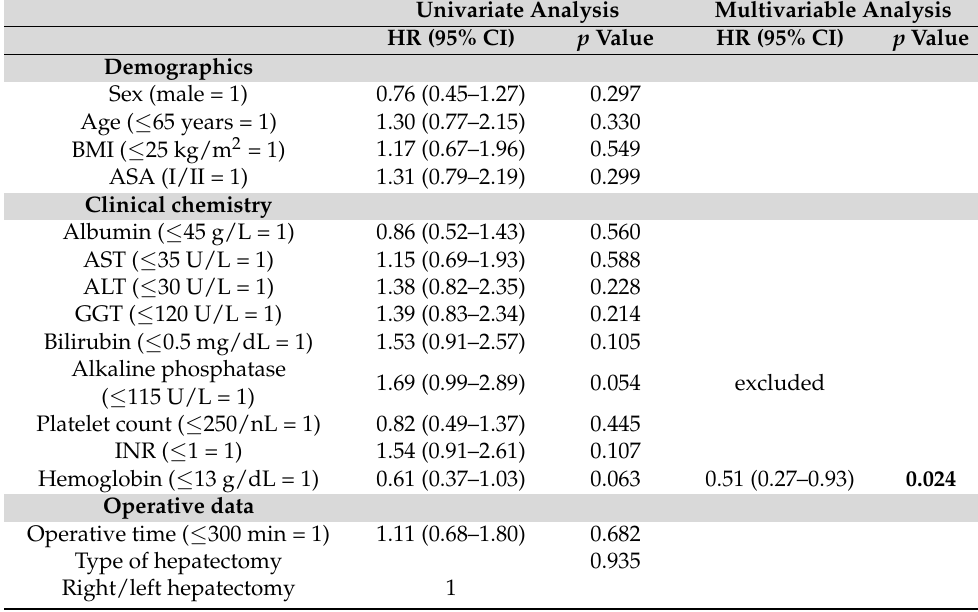
Table 2. Univariate and multivariable analysis of cancer-specific survival in intrahepatic cholangio- carcinoma. Various parameters are associated with cancer-specific survival. ALT, alanine aminotrans- ferase; ASA, American society of anesthesiologists classification; AST, aspartate aminotransferase; BMI, body mass index; GGT, gamma glutamyltransferase; INR, international normalized ratio; LVI, lympho-vascular invasion; MVI, microvascular invasion; NF, nerve fibers; PNI, perineural